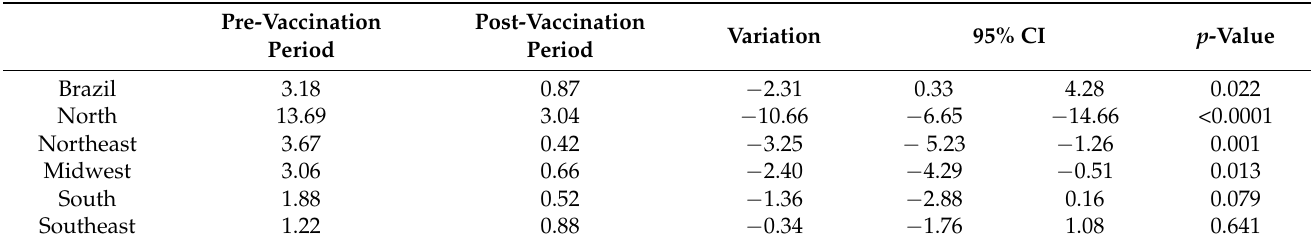
Table 1. Comparative analysis of incidence rates before and after the hepatitis A introduction in the National Immunization Program, according to Brazilian geographic region.